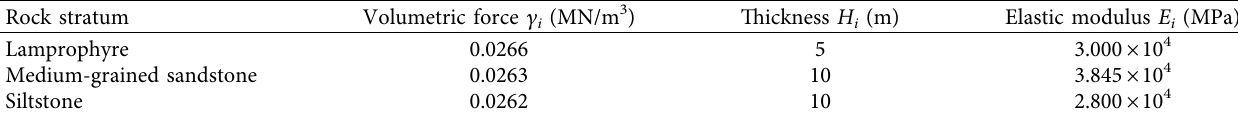
Table 1: Mechanical parameters of interlayer strata.